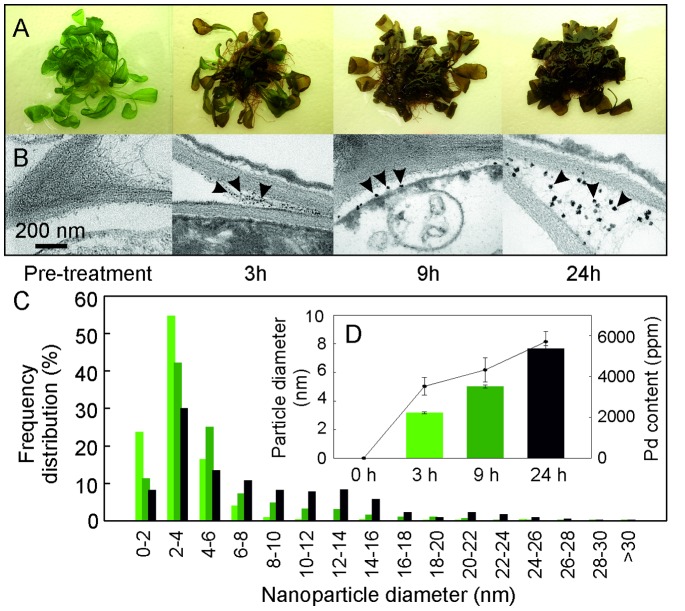
Pd uptake and PdNP formation in Arabidopsis: (A) appearance of 3-week-old plants 24 h after treatment with K2PdCl4.(B) TEM showing accumulation over time of PdNPs in cell wall corners. (C) Distribution of NP sizes in leaf tissue with time. (D) Mean NP diameter and Pd concentration with time.